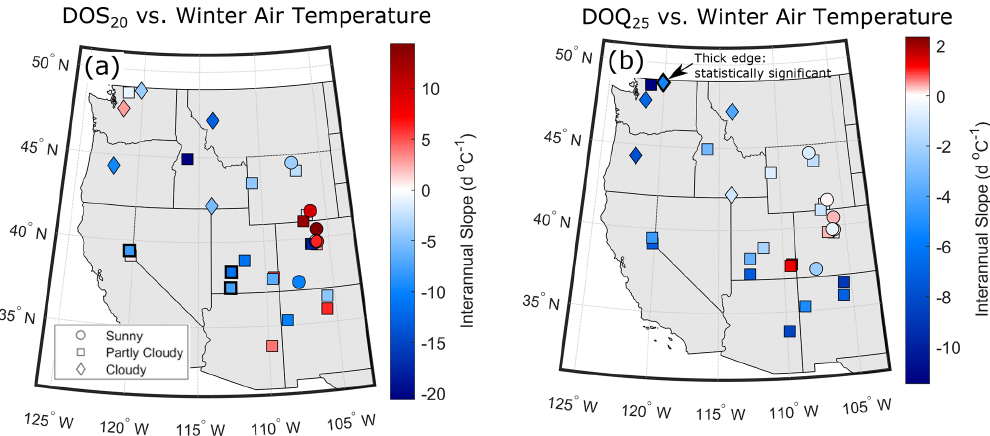
Figure 4. Spatial variability in watershed-level interannual slopes for (a) DOS 20 versus winter air temperature and (b) DOQ 25 versus winter air temperature. Watersheds with statistically significant relationships are highlighted in symbols with thicker edges and are associated with those presented in Fig. 3. Symbols are associated with the mean annual percentage of snowmelt days under clear-sky conditions. Sunny sites (circles) have > 90% clear-sky snowmelt days, partly cloudy sites (squares) have between 70% and 90%, and cloudy sites (diamonds) have < 70% clear-sky snowmelt days. Clear-sky snowmelt days are defined as those with more than 80% of the potential clear-sky solar